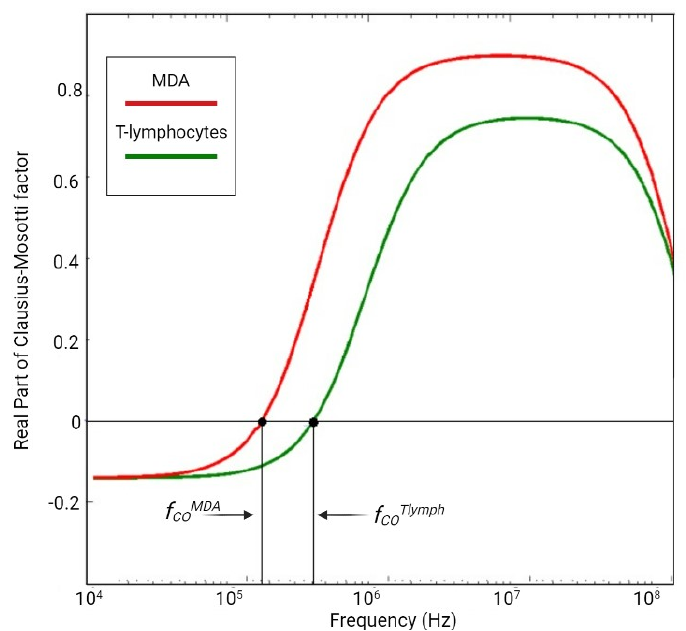
Figure 2. Clauss ‐ Mosotti function for MDA, a CTC derived from breast cancer, versus healthy cells in peripheral blood.